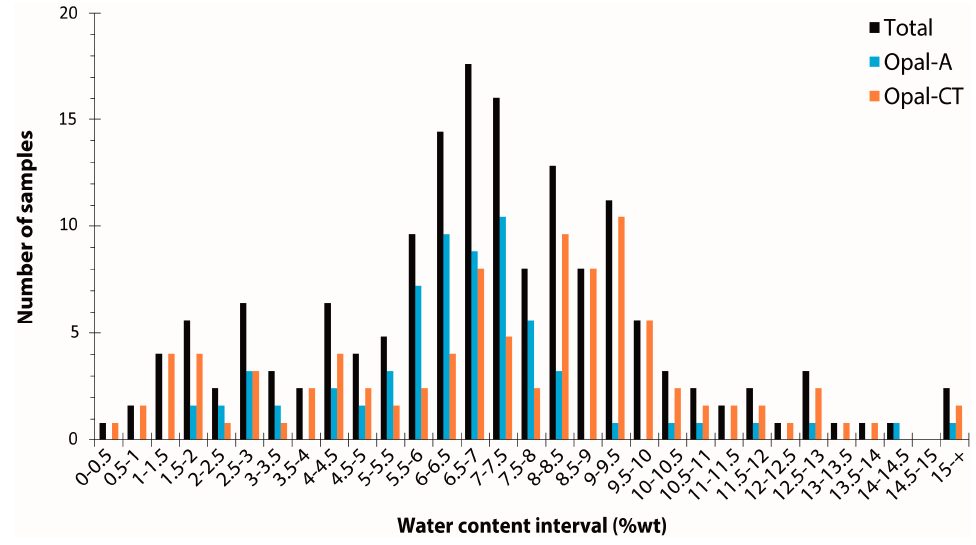
Figure 2. Meta-analysis of the water content found in the literature [3,6,12,46,51–61].